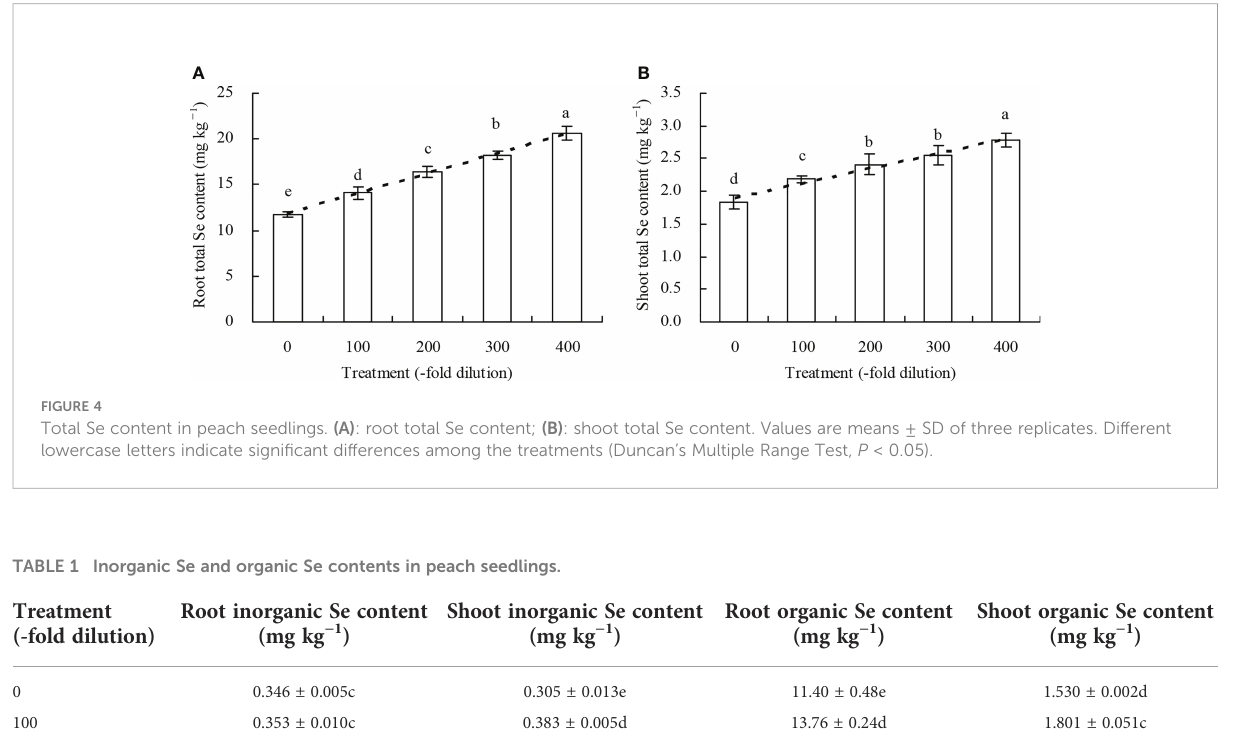
activity, and ATPS activity with shoot total Se content, and were also the top three closest relationships.